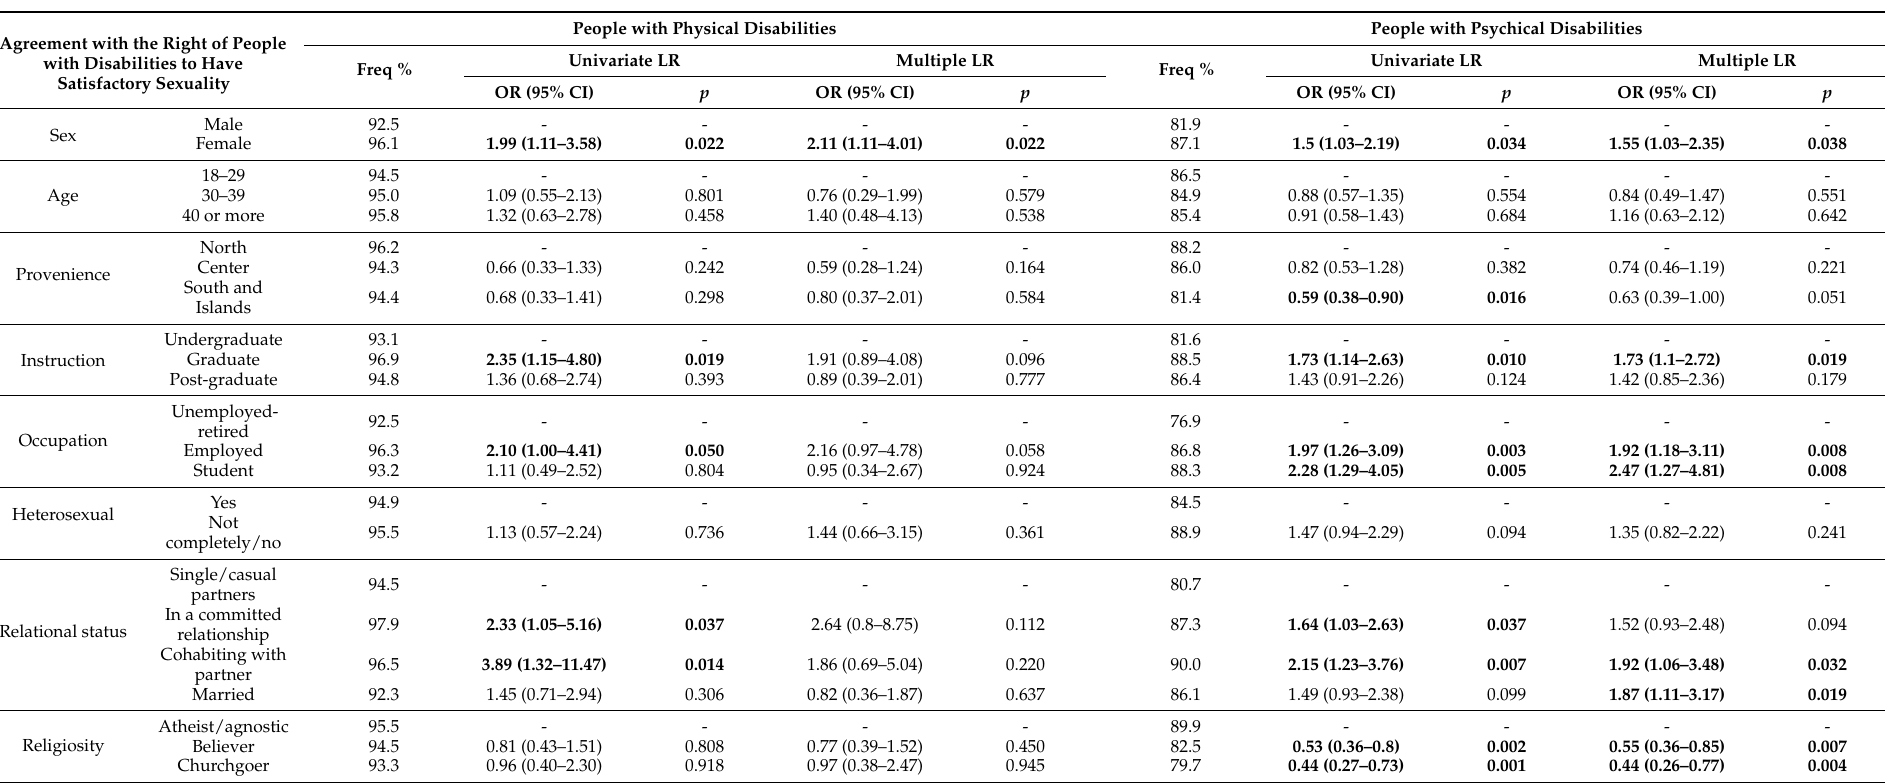
Table 2. Socio-demographic features and percentages of agreement with the right of people with physical and psychical disabilities to have satisfactory sexuality: Frequencies (in percentages) and results of the univariate and multiple logistic regression analyses. Significant differences with respect to the reference are reported in